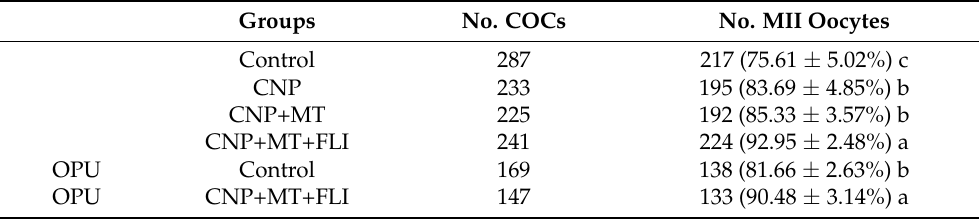
Table 2. The combination treatment of CNP, MT, and FLI on the maturation ability of oocytes.